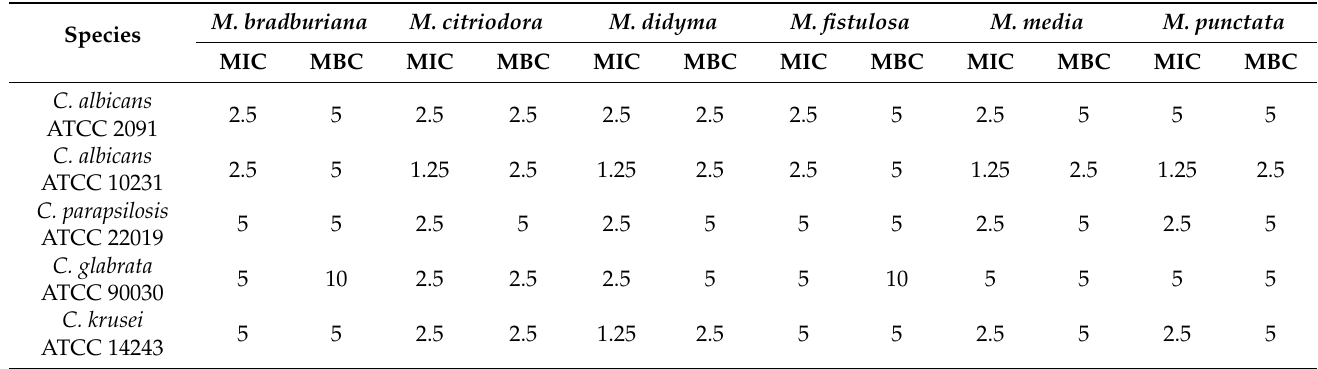
Table 5. Antimicrobial activity in vitro of 70% ( v/v ) methanolic extracts of Monarda species expressed as MIC and MFC [mg/mL] values against the reference strains of fungi. The representative values (mode) are